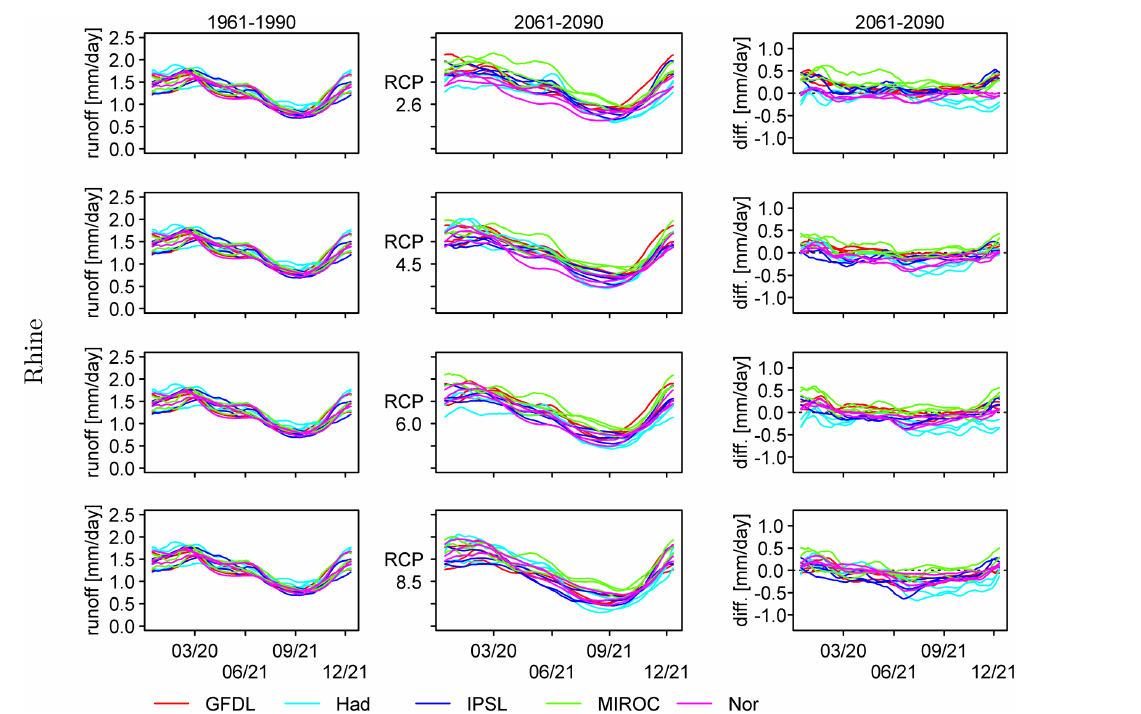
Figure 6. Simulated long-term average seasonal dynamics of river discharge in the reference period 1961–1990 and scenario period 2061– 2090 for four RCPs, and the differences in discharge between these two periods; simulations are differentiated by colors corresponding to climate models, whereby three simulations produced by three hydrological models have the same color.